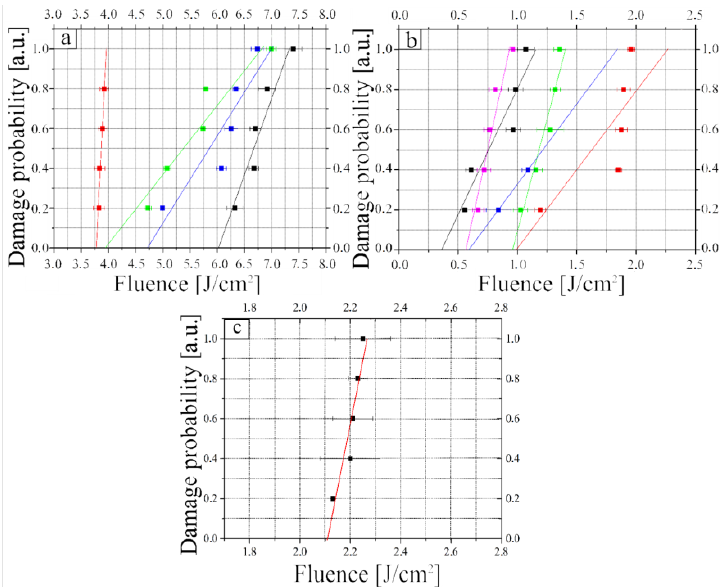
Figure 8. Probability of the optical damage on the energy fluence for the N2 sample ( a ), the N1 sample ( b ), and the N3 sample ( c ) for deferent PRR varied from 12 kHz (red squares), 20 kHz (green squares), 25 kHz (blue squares), 30 kHz (purple squares), and 40 kHz (black squares) at the corresponding pulse width (varied from 18 ns to 45 ns, respectively), the exposure duration of 1 s, and the beam diameter of 180 μm.